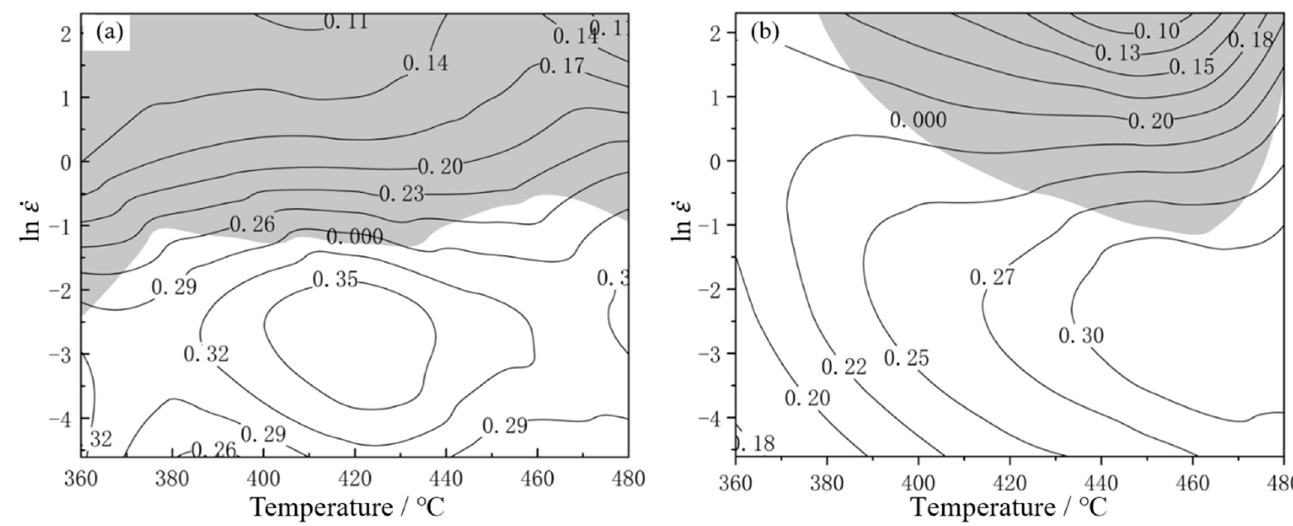
Figure 6. Processing map of AC and HG 2195 Al-Li alloys under different hot deformation conditions: ( a ) AC 2195 Al-Li alloy, ( b ) HG 2195 Al-Li alloy.